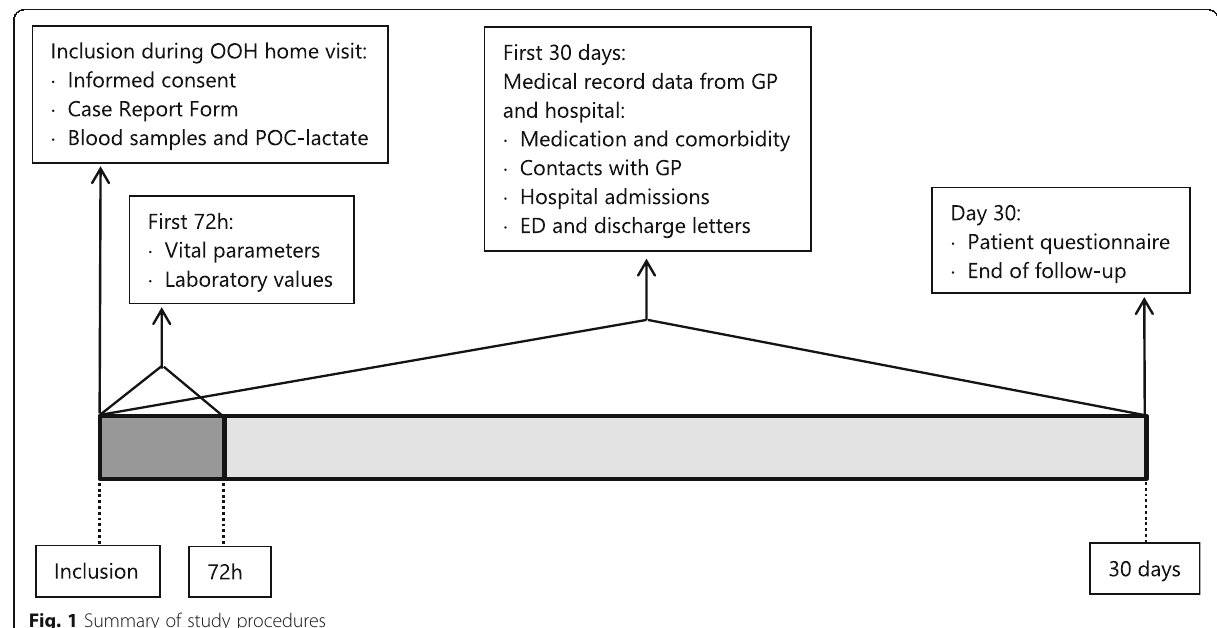
Fig. 1 Summary of study